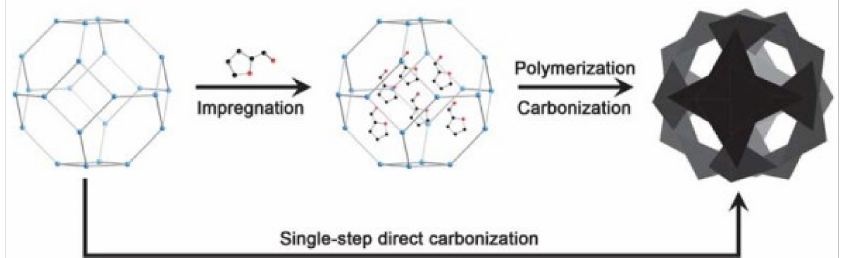
Figure 4. Schematic representation of porous carbons from MOF with furfuryl alcohol as an additional carbon source and direct carbonization of MOFs. Reproduced from ref. [65]. Copyright © (2013) with permission from the Royal Society of Chemistry.